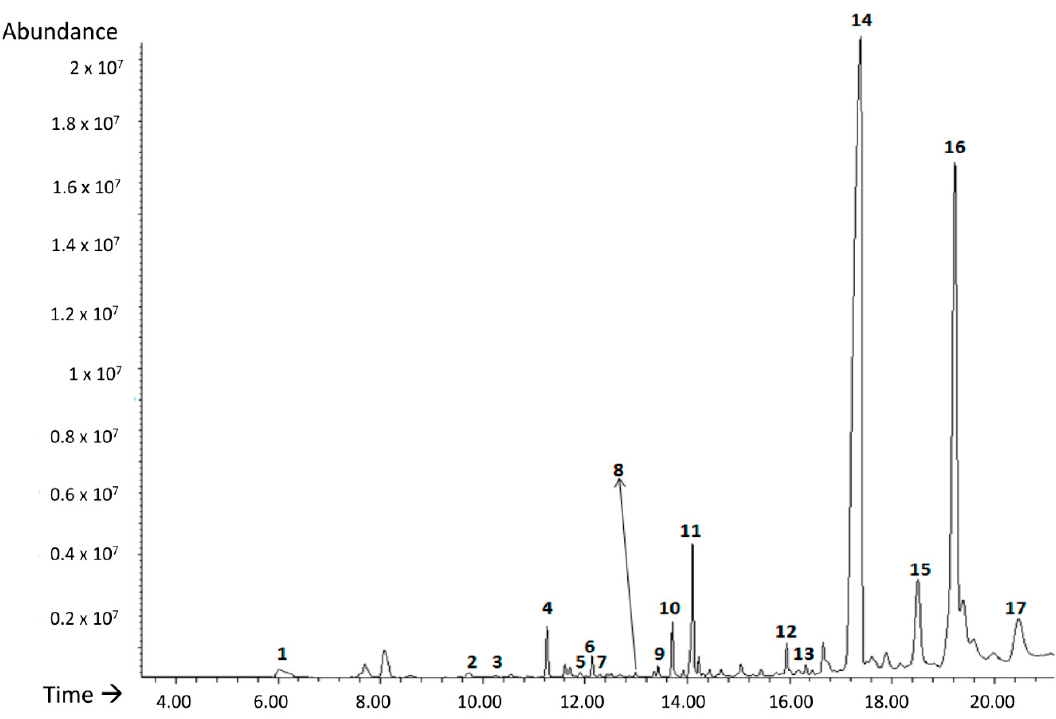
Figure 3. TIC chromatogram obtained for PHB 226 sample under run 3 of the BBD. * Time refers to s